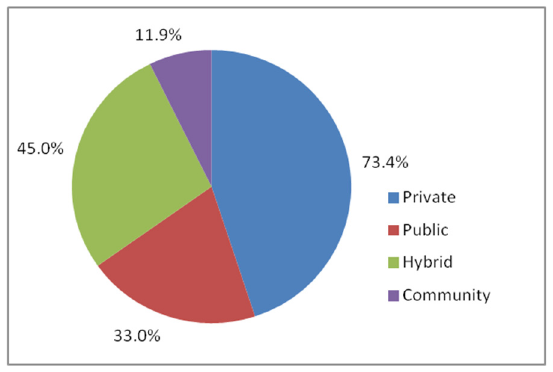
Figure 19. Cloud ERP (C-ERP) service models deployment adoption.